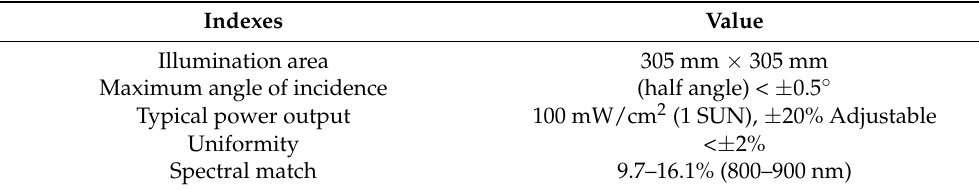
Table 3. Some performance indexes of the Newport Oriel Sol3A Solar Simulator, Model 94123A.